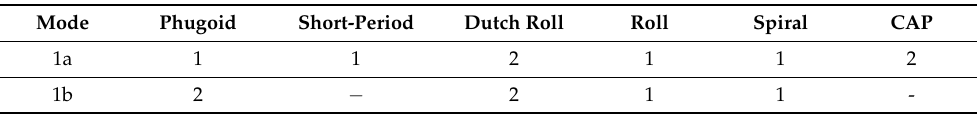
Table 11. Handling Qualities for all-natural modes ( − means that not even level 3 criteria are met by at that mode or a